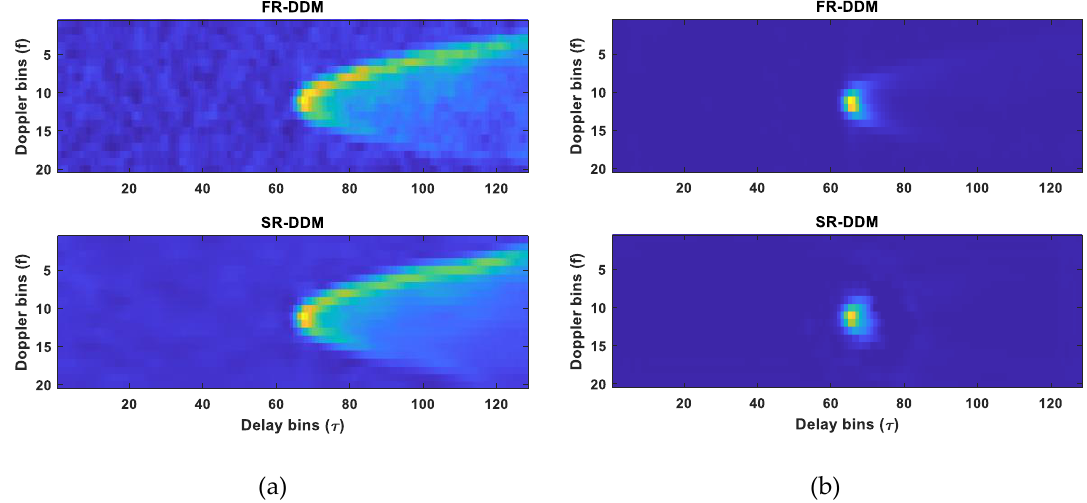
Figure 9. Quality of DDM reconstruction for different satellites. ( a ) Peak signal-to-noise ratio (PSNR) values versus satellite number for SR-DDM and LSR-DDM with one sigma variation. ( b ) Structural similarity index (SSIM) values versus satellite number for SR-DDM and LSR-DDM with one sigma variation.